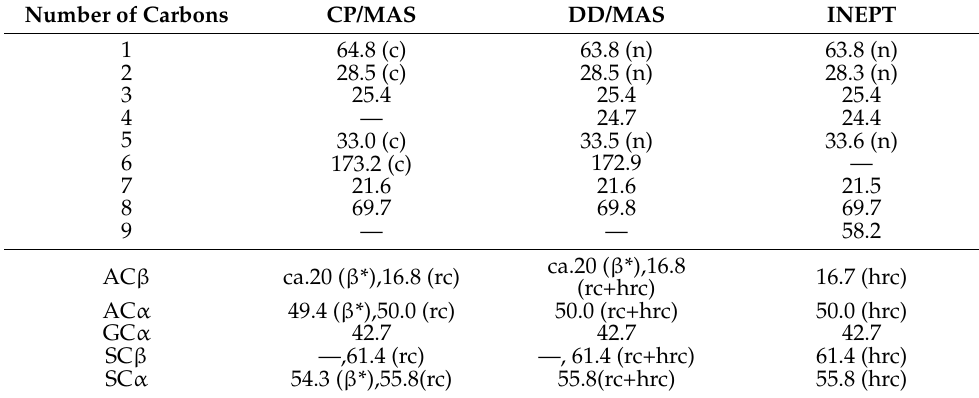
Figure 5. Expanded ( a ) 13 C r-INEPT, ( b ) 13 C DD/MAS, and ( c ) 13 C CP/MAS NMR spectra (10–80 ppm) of Sample III in the hydrated state. β *: anti-parallel β -sheet, rc: random coil, and hrc: hydrated random coil. The number of each carbon indicates the PU peaks noted in Figure 1. Table 2. 13 C chemical shifts (ppm) of 13 C CP/MAS, 13 C DD/MAS, and 13 C r-INEPT NMR spectra of Sample III in the hydrated state together with the